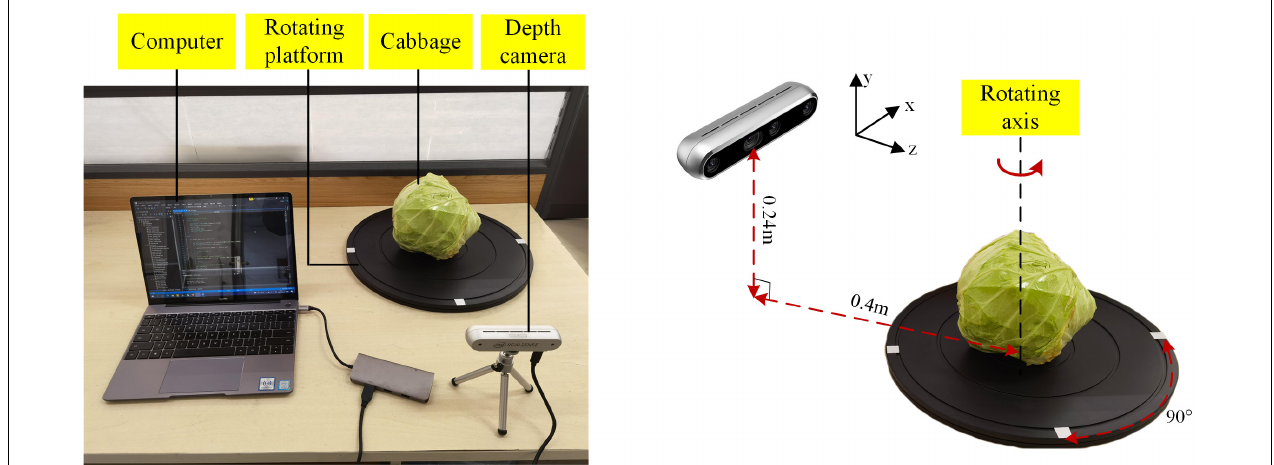
FIGURE 1 | 3D point cloud reconstruction system.